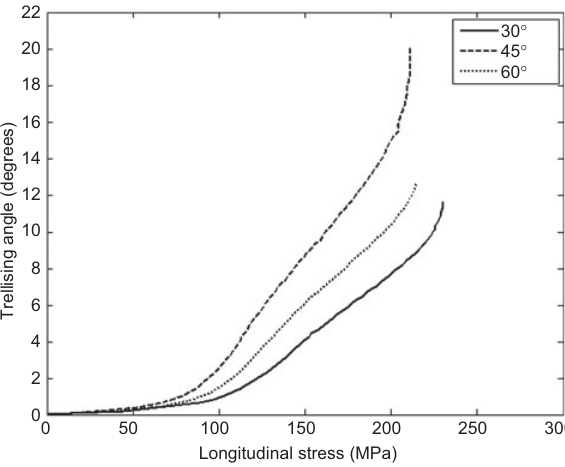
Figure 8 Evolution of apparent Poisson ’ s ratio. Figure 9 Yarn trellising angle for off-axis